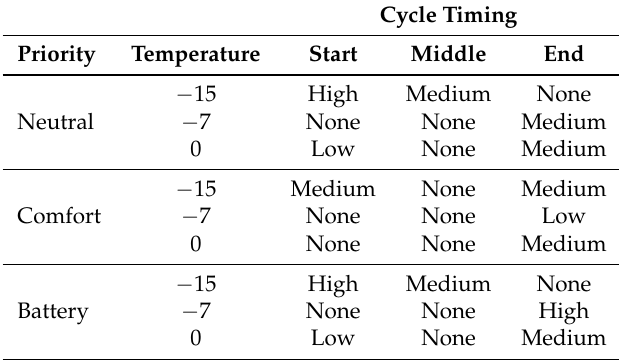
Table 11. Recommendation of when to heat the battery during a drive cycle under different conditions, and by how much. Here, Start, Middle, and End refer to the first, second, and third 600 s of the drive cycle; and None, Low, Medium, and High refer to the discretisation levels of U ( k ) described in Section 5.1. Cycle Timing Priority Temperature Start Middle End − 15 High Neutral